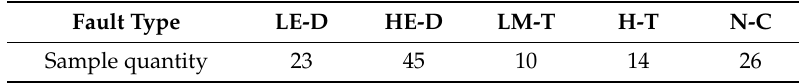
Table 5. Transformer fault sample